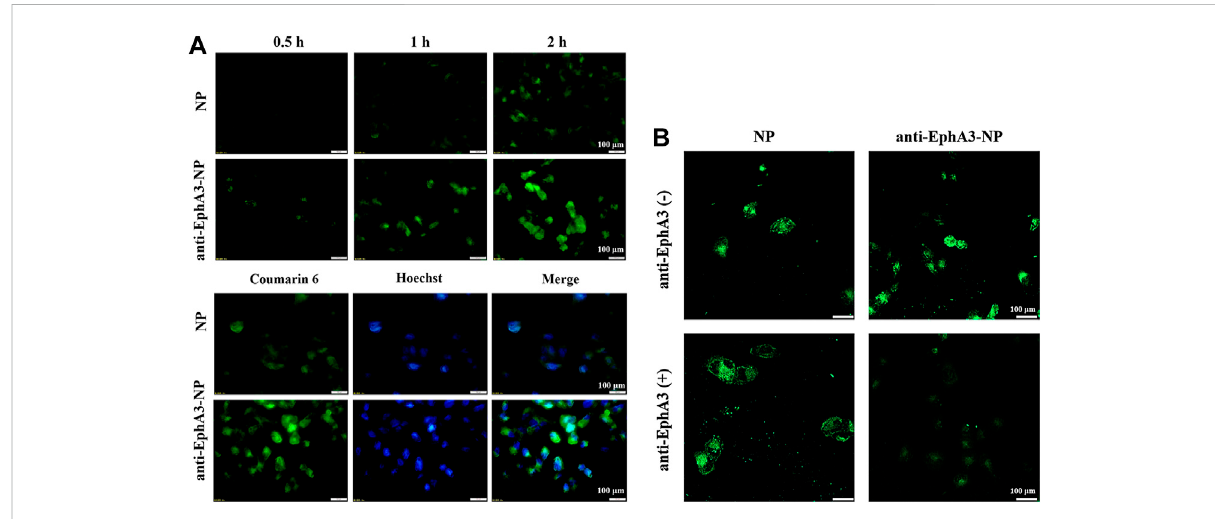
FIGURE 4 (A) Cell uptake and intracellular localization of NPs and anti-EphA3-NPs by T98G cells. (B) Cell uptake of NPs and anti-EphA3-NPs with pre- incubated (+) and non-pre-incubated ( − ) anti-EphA3 by T98G cells.